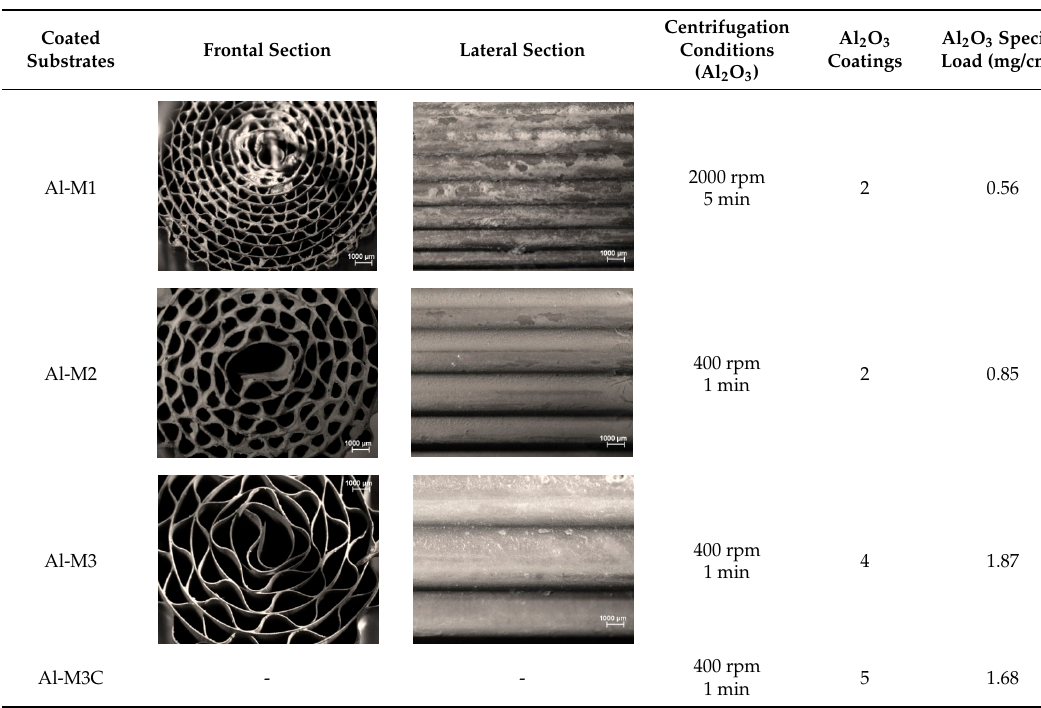
Figure 1. FeCrAlloy ® monoliths used as substrates for the catalytic coatings depositions. Table 1. Characteristics and preparation conditions of the coated substrates.